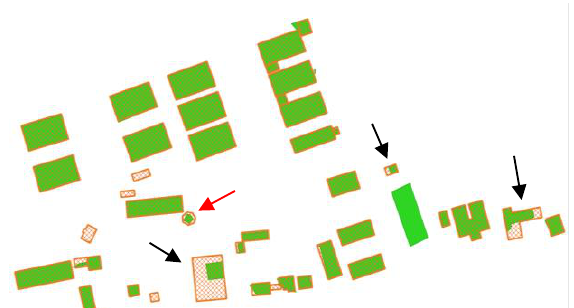
Figure 10. Base map (orange) and buildings from adaptive RanSAC (green)